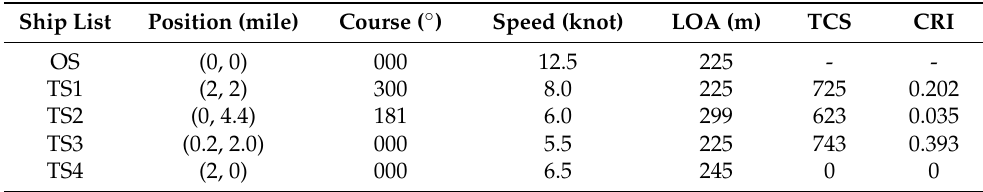
Table 3. Initial information of the ships for simulation in scenario